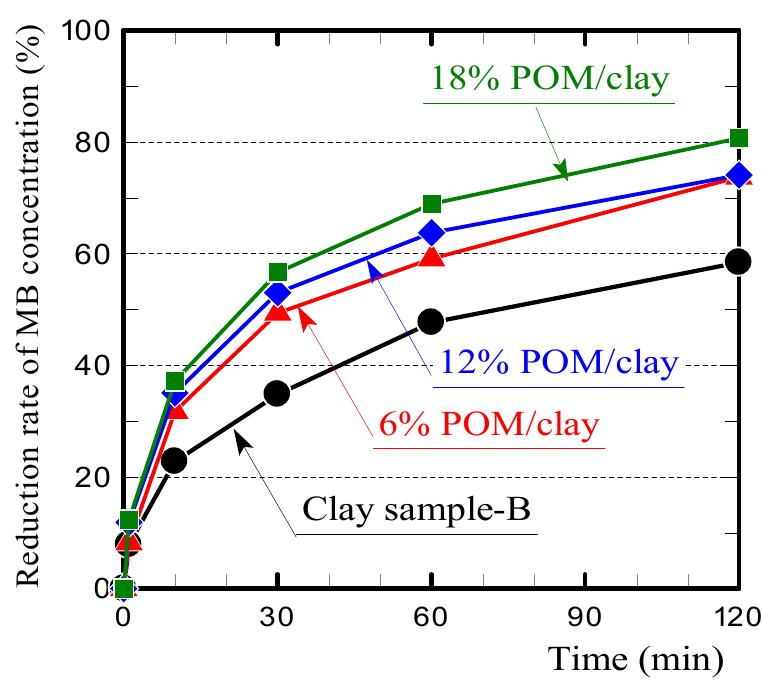
Figure 13. MB concentration reduction rates on POM/clay ceramics.